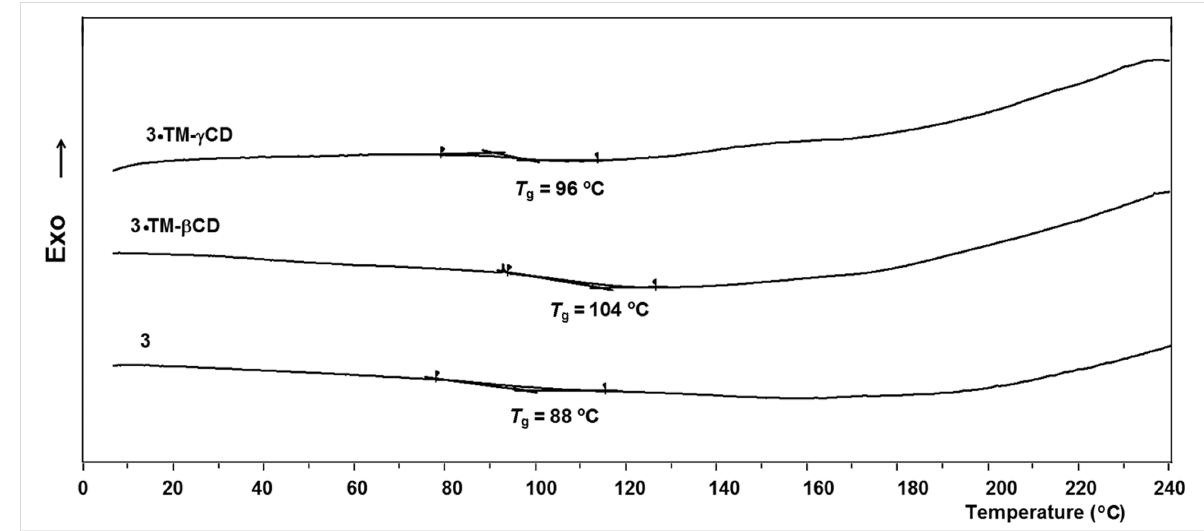
The absorption spectra of 3·TM- β CD and 3·TM- γ CD polyro- taxanes and the unthreaded 3 counterpart at a concentration of 10 − 1 mg ∙ mL − 1 in CHCl 3 are reported in Figure 3a. The non- rotaxane 3 copolymer shows a featureless band peaking at 374 nm. Upon encapsulation with the TM- β CD, we note a hypsochromic shift of about 7 nm that can be attributed to a reduction of intermolecular interactions and/or a variation of